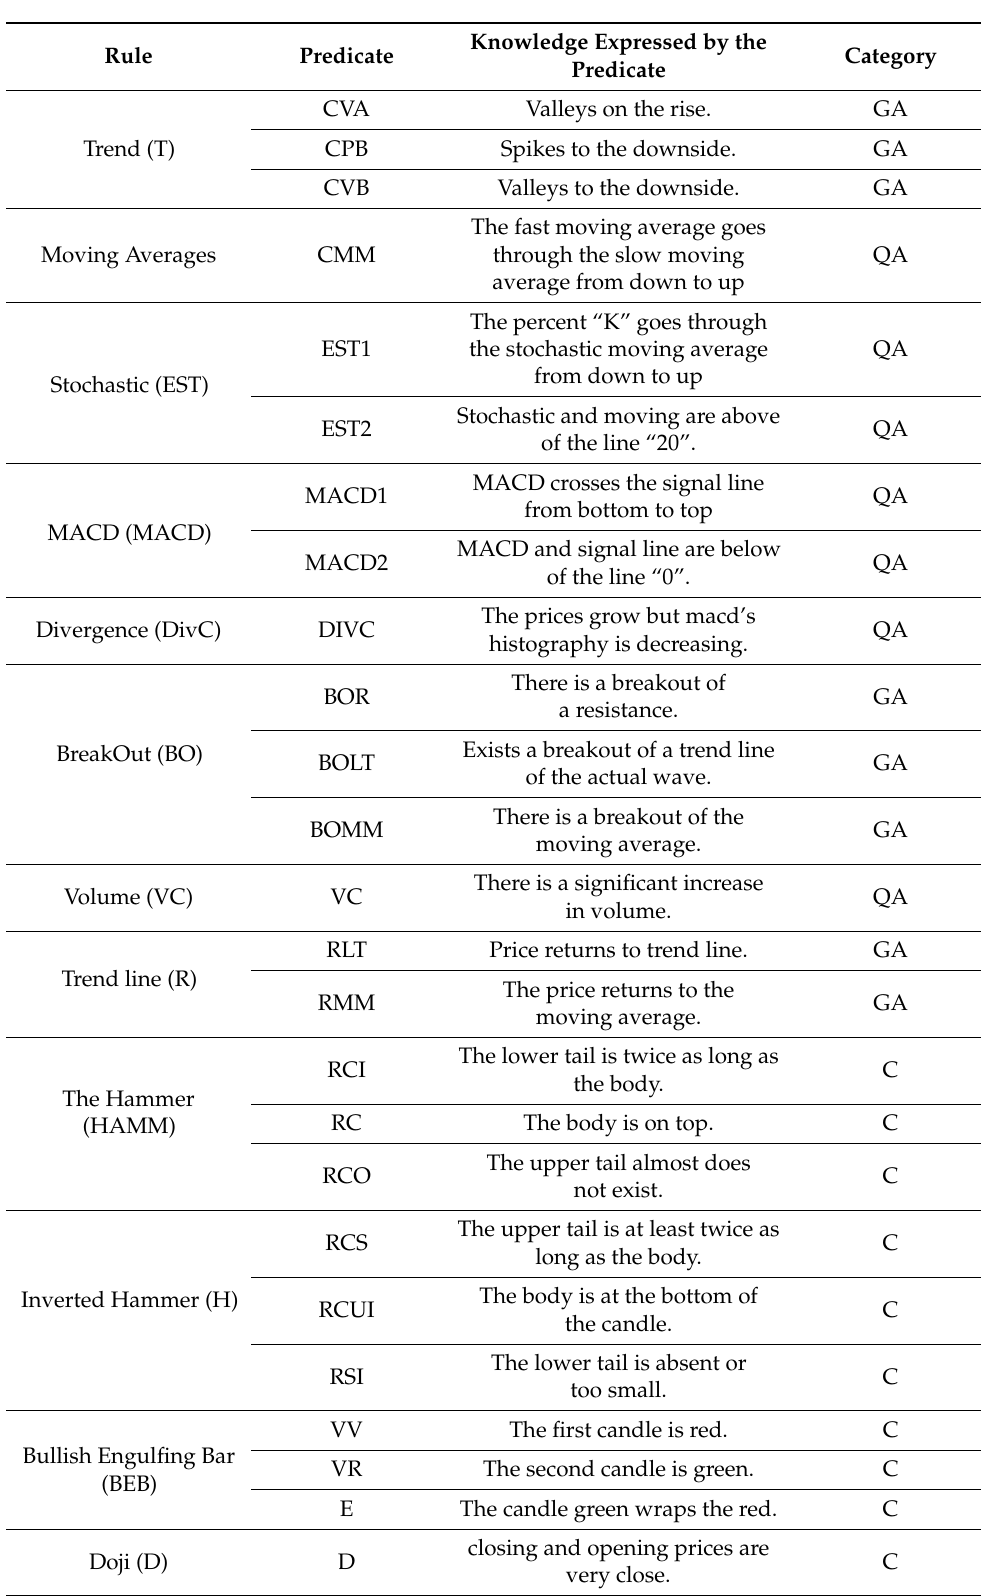
Table A2. Cont. Knowledge Expressed by the Category Rule Predicate Predicate CVA Valleys on the rise. GA CPB Spikes to the downside. GA Trend (T) CVB Valleys to the downside. The fast moving average